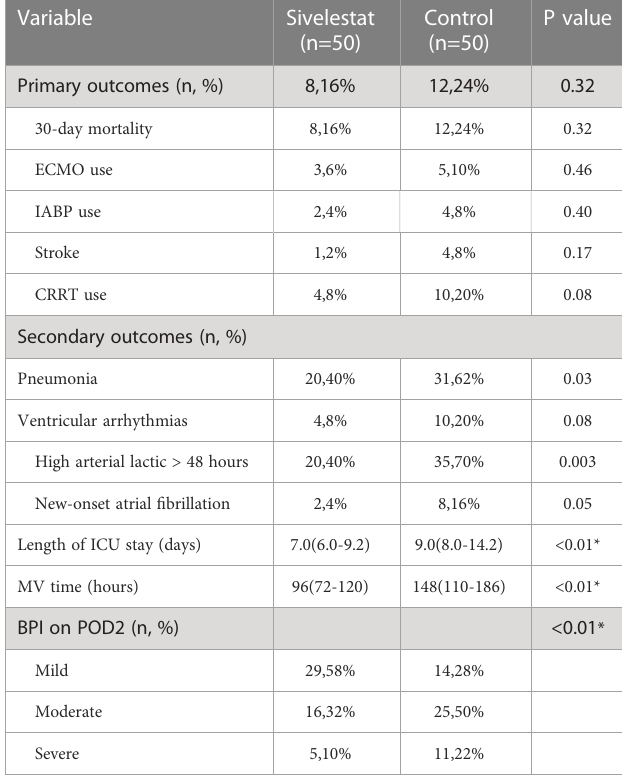
TABLE 1 Postoperative outcomes in propensity-matched